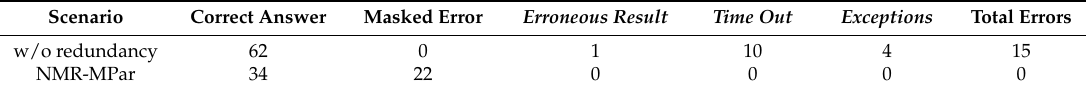
Table 8. SEE Sensitivity of the